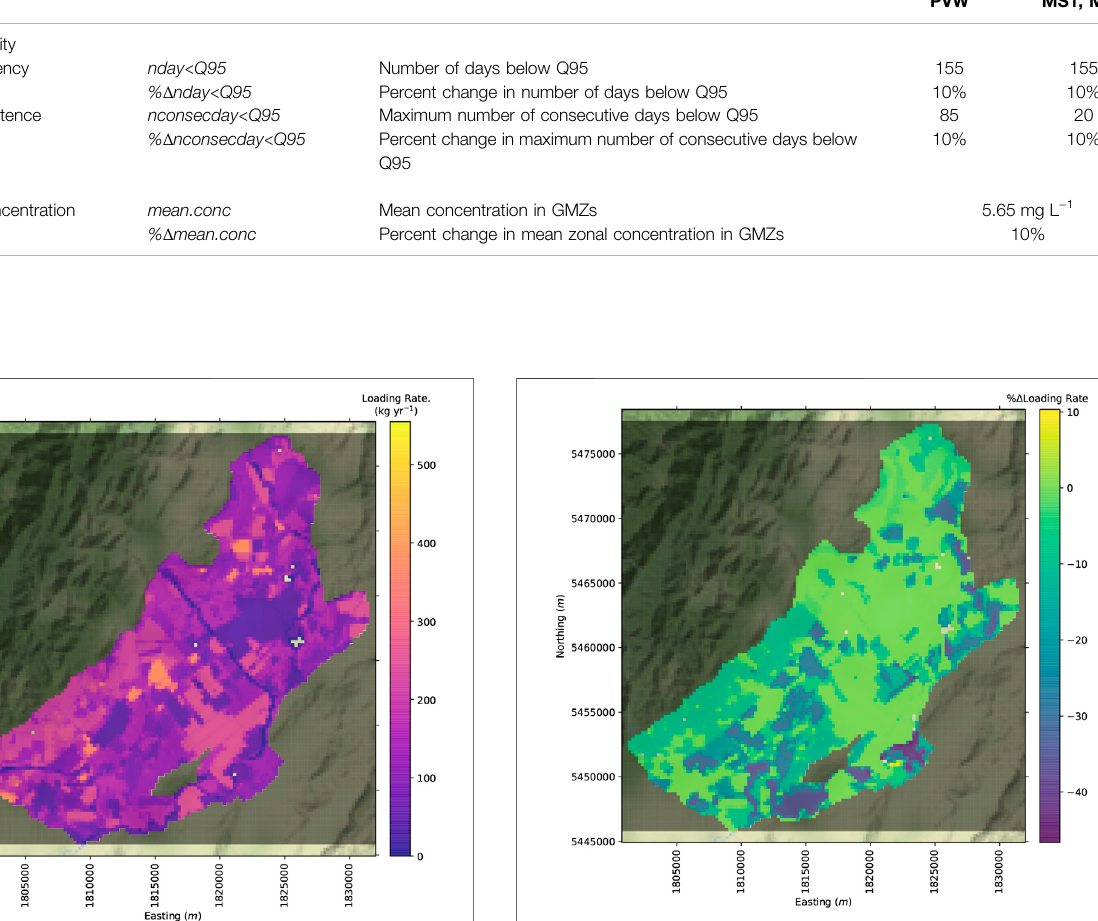
TABLE 1 | Decision-relevant forecasts. PVW, MS1 and MS2 relate to the stream fl ow reliability forecast sites in Figure 1 . GMZs refers to groundwater management zones. Forecast